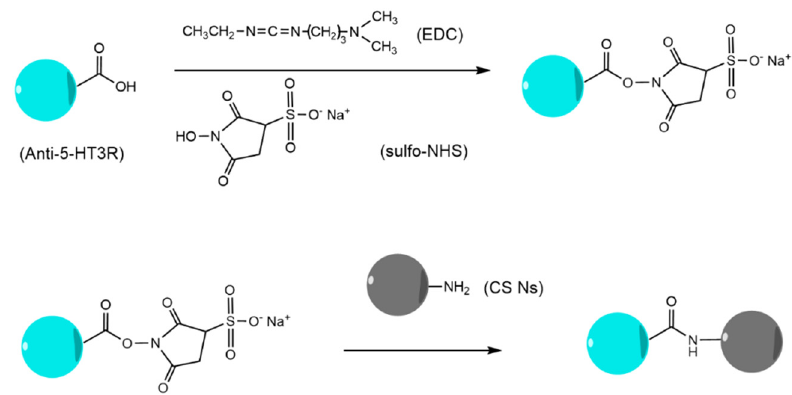
Figure 4: The mechanism of antibody - conjugation on the surface of CS Ns.